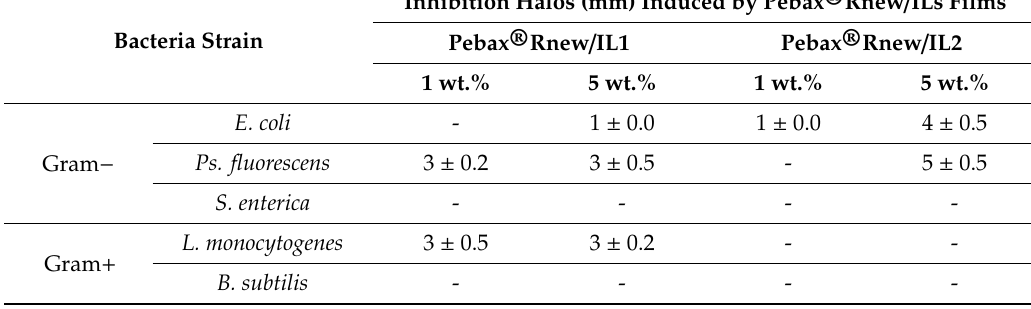
Table 4. Inhibition halos (mm) induced by Pebax ® Rnew / ILs films, after 48 h of incubation, on nutrient agar (NA) plates containing bacterial